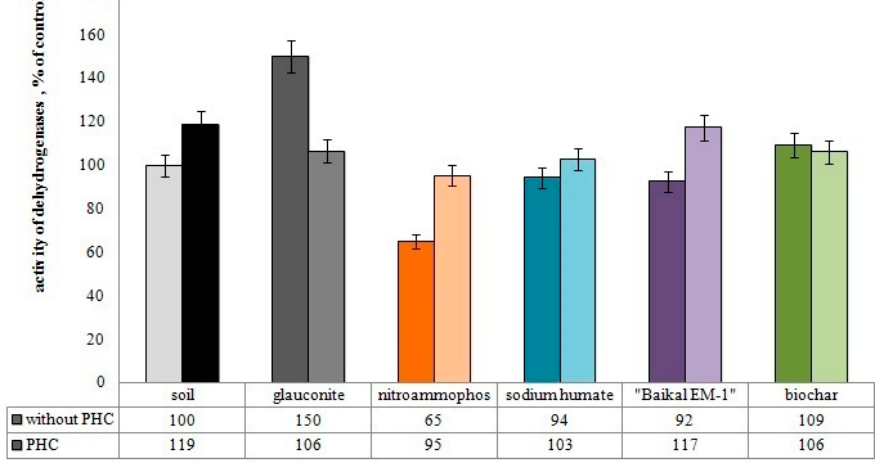
Figure 8. Changes in the activity of dehydrogenases in non-contaminated Haplic Chernozem Calcic soil after adding various bioremediators, % of control. Note: PHC, petroleum hydrocarbon.